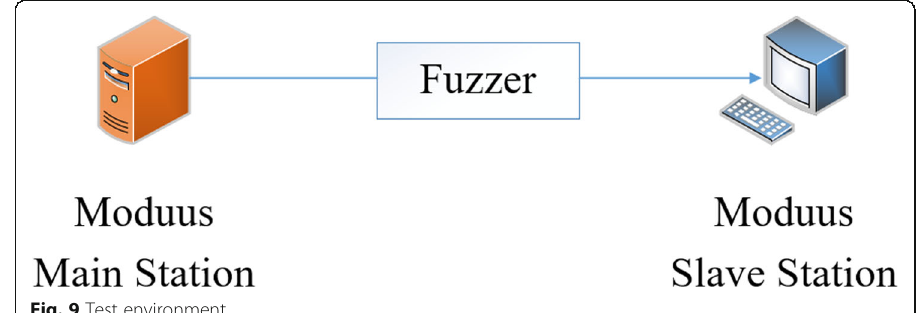
Fig. 9 Test environment